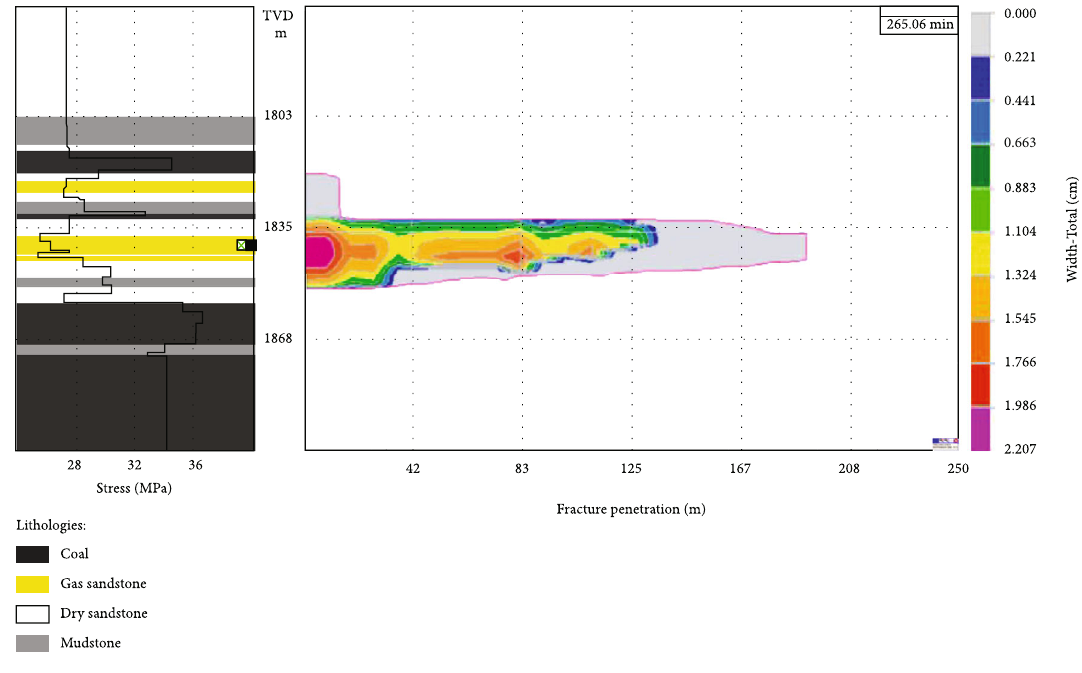
Figure 18: The optimized hydraulic fracture for well X-1.